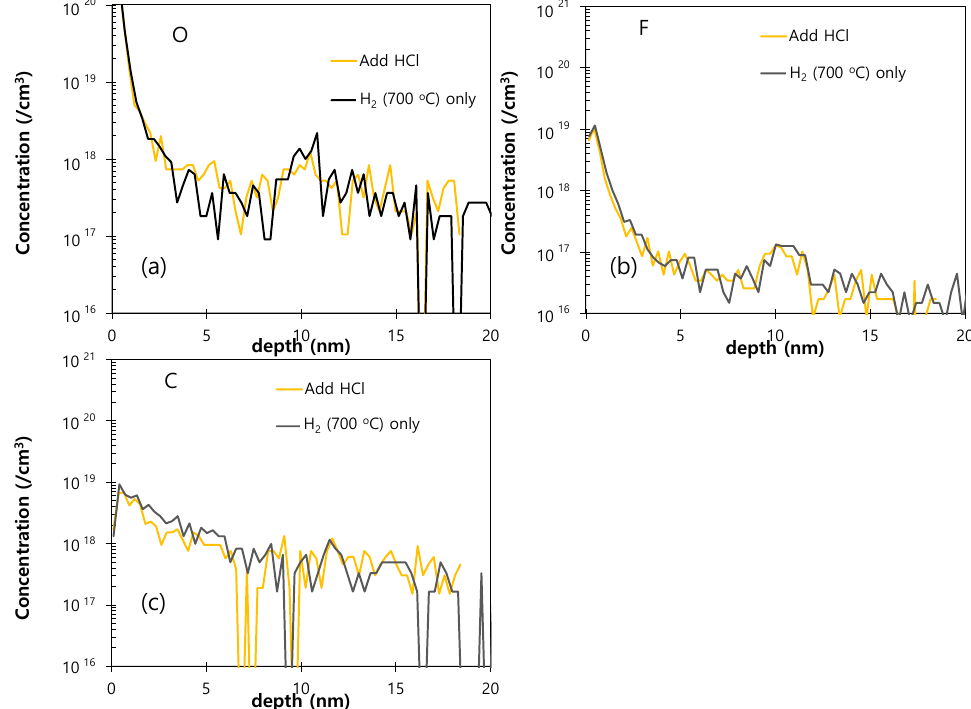
Figure 10. The SIMS O ( a ), F ( b ), and C ( c ) profiles of the Si epitaxial films obtained after ex-situ dry pre-cleaning and subsequent in-situ bake in the presence of H 2 and then HCl at 700 °C.